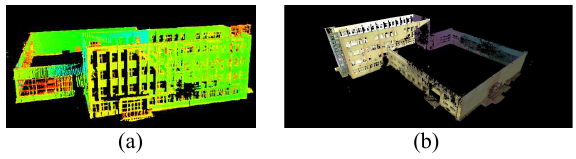
Figure 11. The point cloud for the study building after the filtering process containing information about (a) the reflectance (b) the real color